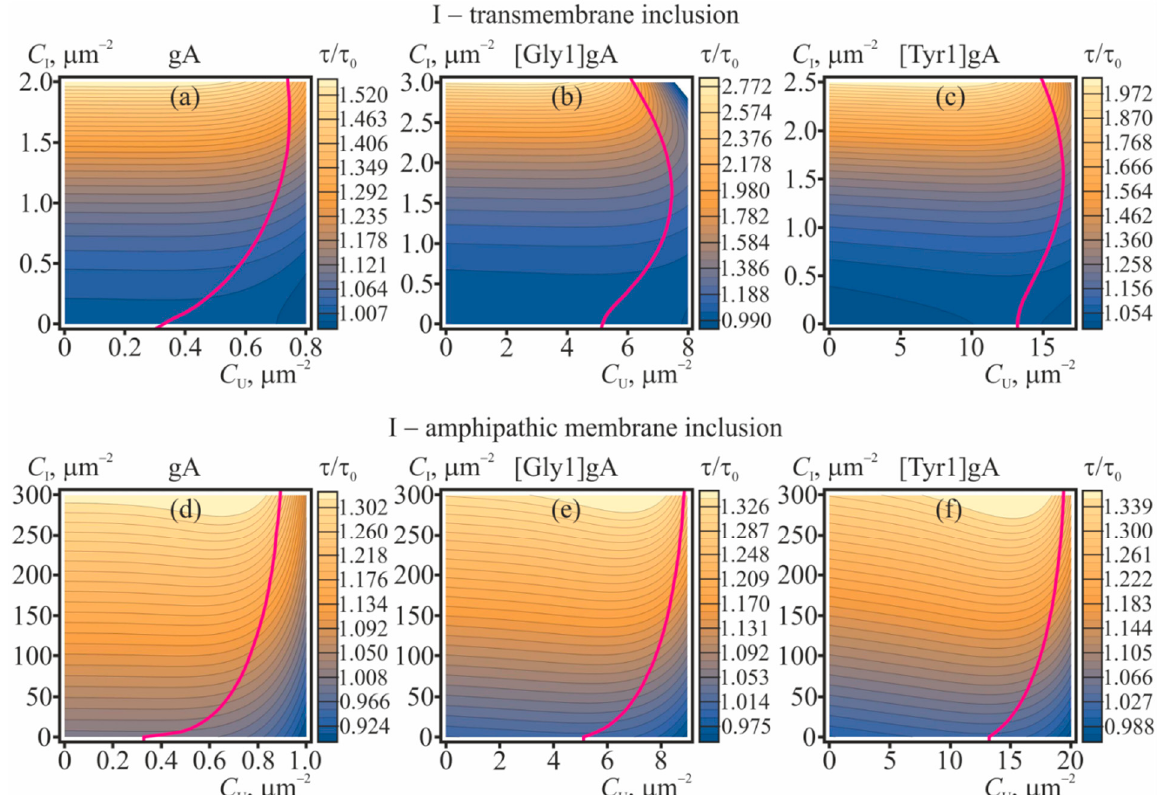
Figure 5. The dependence of the dimer lifetime (relative to its value in the “ideal” case) on concentrations of gramicidin monomers and membrane inclusions: ( a – c )—transmembrane inclusions; ( d – f )—amphipathic membrane inclusions, incorporated into the top monolayer. The value τ / τ 0 is plotted for: ( a , d )—gA; ( b , e )—[Gly1]gA; ( c , f )—[Tyr1]gA. The magenta curves bound the range of concentrations where the correction to the main approximation calculated within the perturbation theory reaches 20%; for larger C U , C I concentrations the application of the perturbation theory is not strictly valid. The illustrated dependences of τ / τ 0 were obtained based on Equation (29).